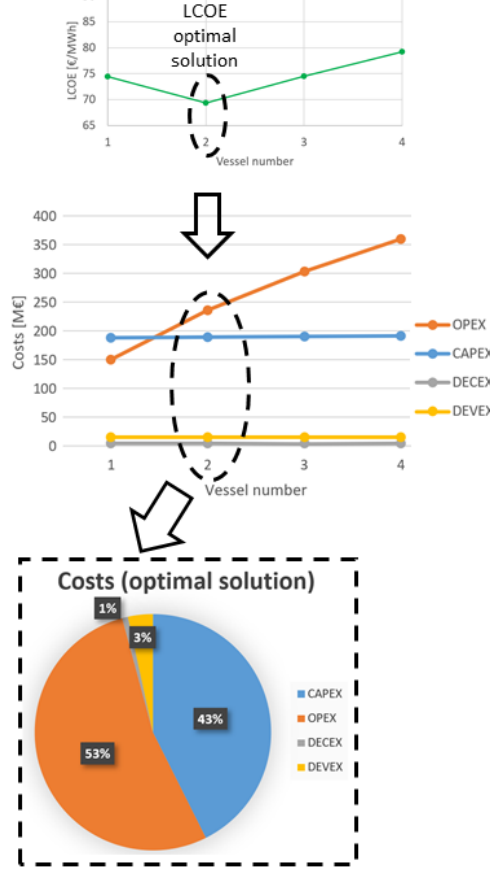
Fig. 32. Cost breakdown for the optimal O&M